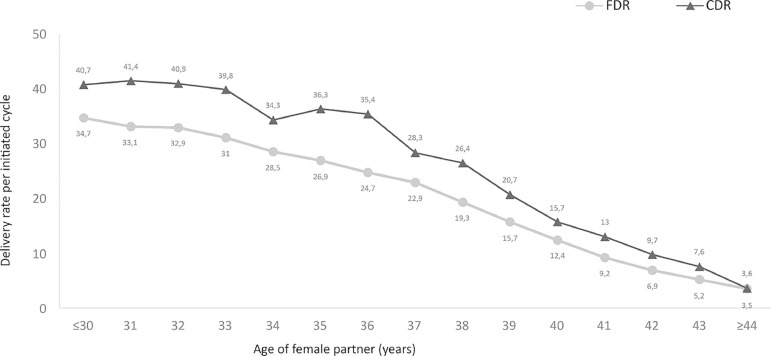
Cumulative delivery rate (CDR) and fresh delivery rate (FDR) per
initiated cycle from 2012 to 2015, according to a woman's age